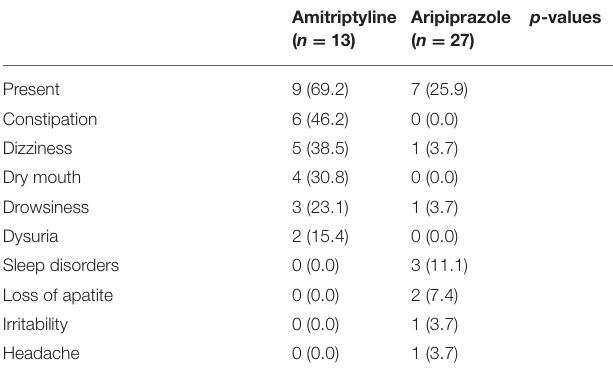
TABLE 1 | The clinical differences between amitriptyline and aripiprazole in very elderly patients with BMS.